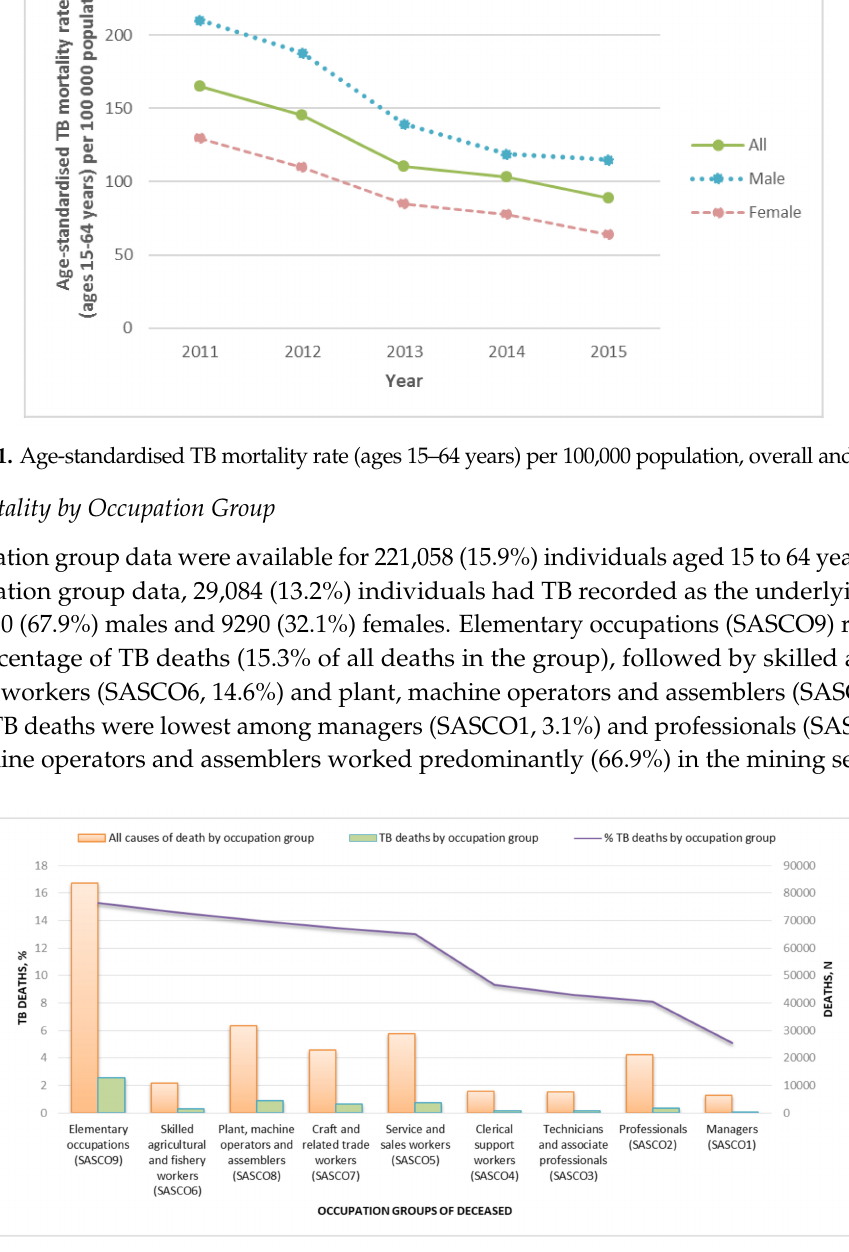
Figure 2. Percentage and number of TB deaths by occupation groups, 2011–2015 ( n =